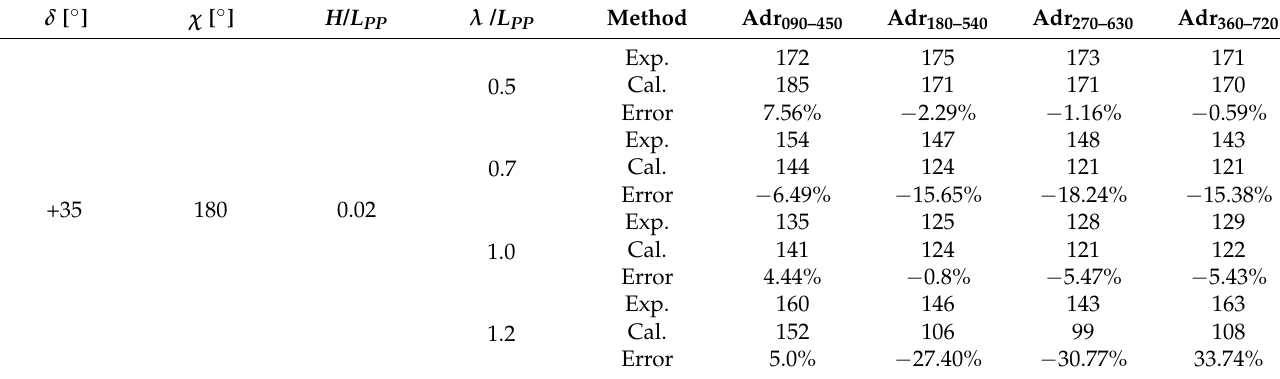
Table 5. Comparisons of trajectory drifting angle in head waves [unit: